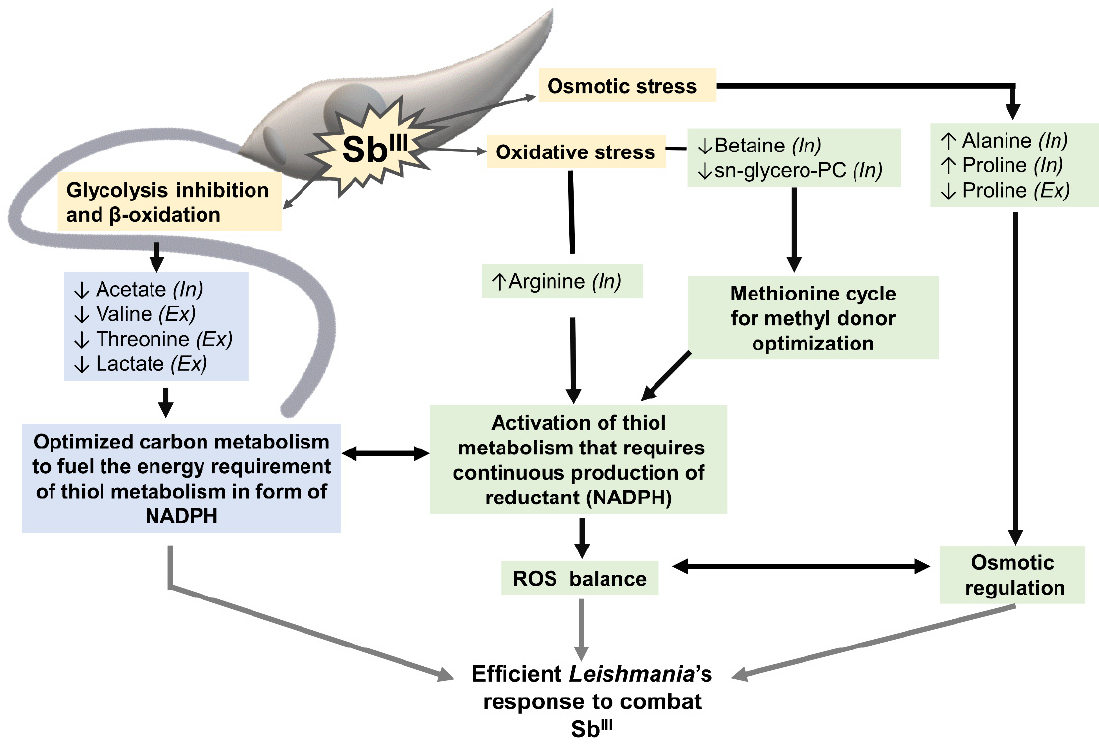
Figure 8. Sb III -resistant parasites showed a coordinated metabolomic remodeling to combat the stress caused by the drug. Yellow boxes highlight some of the effects typically caused by Sb III in Leishmania parasites: glycolysis and β - oxidation inhibition, osmotic and oxidative stress. Green boxes highlight the group of metabolites contributing to the osmotic/oxidative balance and thiol metabolism activation. Blue boxes show the metabolites potentially contributing to the energy metabolism required to fuel thiol metabolism in the form of NADPH. This coordinated metabolic response is essential to develop resistance and combat the drug efficiently in Leishmania parasites. Metabolites increased in Sb III -resistant parasites ( ↑ ). Metabolites decreased in Sb III -resistant parasites ( ↓ ). Metabolites differentially detected at the intracellular (In) and extracellular levels (Ex) .